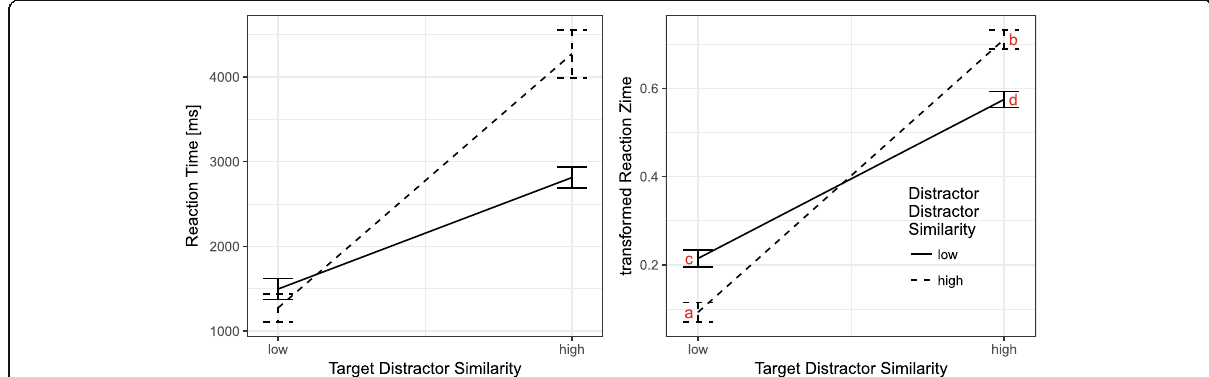
Fig. 4 Interactions of TDS and DDS on reaction time and transformed reaction time. Smaller values indicate a quicker and more efficient search. To compare the results with Fig. 1 and Fig. 3, the letters a to d were added to the graph on the right . All analyses were conducted on transformed reaction times ( right graph ) but original values of reaction time are shown in the left graph for easier interpretation